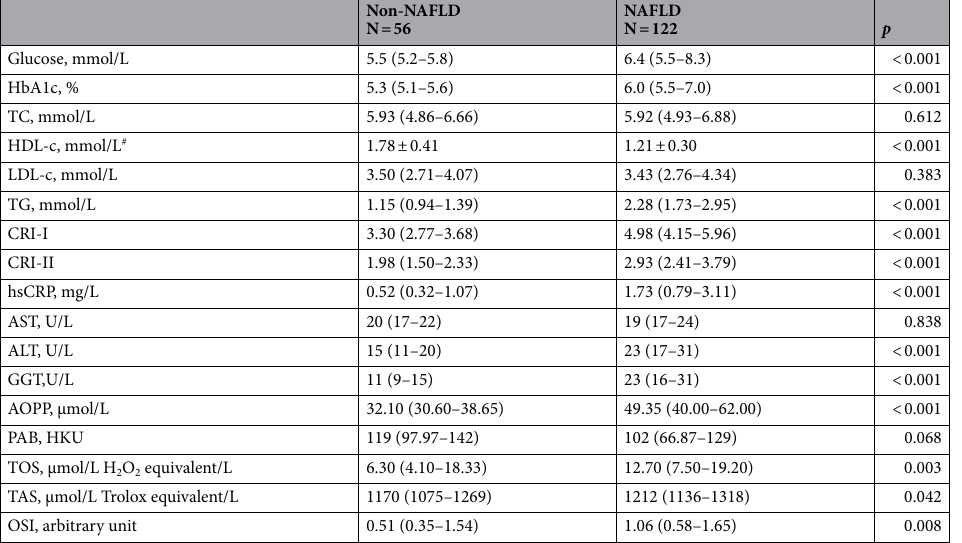
Table 2. Biochemical and oxidative stress status markers of examined population according to NAFLD status. Data are presented as median (interquartile range) and compared with Mann–Whitney U -test. # Normally distributed data are presented as arithmetic mean ± standard deviation and compared with Student t -test. Categorical variables are presented as relative frequencies and compared by Chi-square test for contingency tables. HbA1c-Glycated hemoglobin; TC-Total cholesterol; HDL-c-High density lipoprotein cholesterol; LDL-c-Low density lipoprotein cholesterol; TG-Triglycerides; CRI-I-Castelli’s Risk Index I;